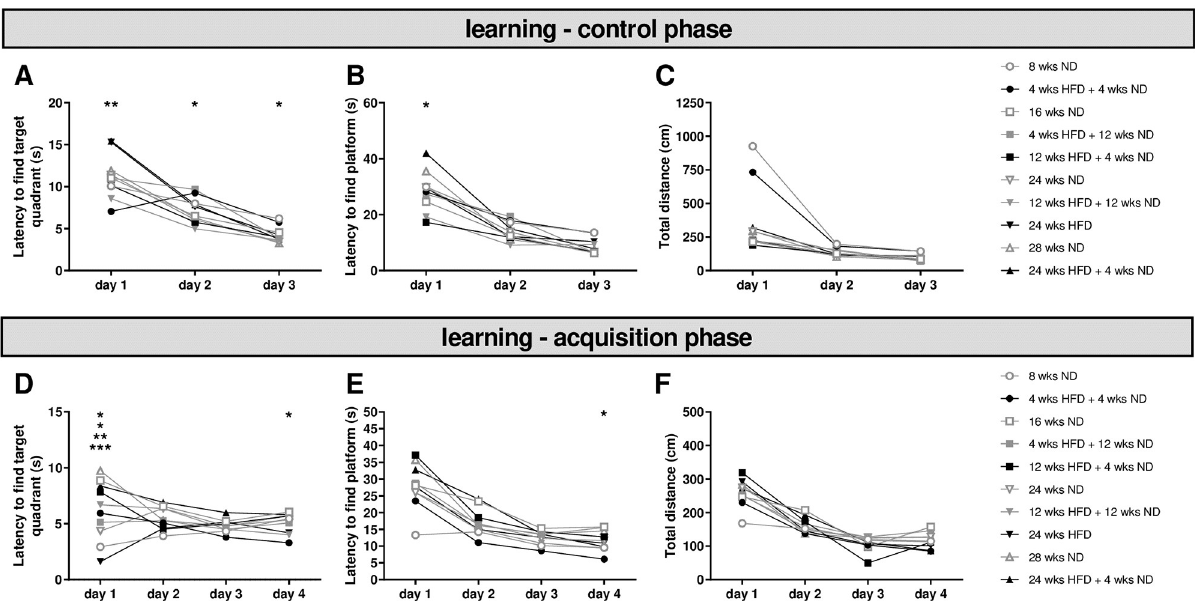
Fig 4. Learning is not affected by HFD. Before performing the MWM test, mice had three days to find the marked platform underneath the water by using visual information (control phase). (A) Diet had an effect on the latency to find the target quadrant. (B) We observed an effect on the latency to find the platform only on the first day regarding diet. (C) The motor activity was not affected by diet and general learning performance did not differ with respect to diet/dietary change. After the control phase, mice were trained for four days to perform the MWM test (acquisition phase). (D) Latency to find the target quadrant differed for some groups on day one and four, but learning did not change due to diet. (E) Latency to find the platform underneath the water surface showed no effect of diet. Performance up to day four did not differ relative to diet. (F) Motor activity was similar for mice on different diets. Data are presented as mean values and error bars indicate SD; 8 wks ND n = 12, 16 wks ND n = 24, 24 wks ND n = 30, 28 wks ND n = 12, 4 wks HFD + 4 wks ND n = 12, 12 wks HFD + 4 wks ND n = 7, 4 wks HFD + 12 wks ND n = 12, 12 wks HFD + 12 wks ND n = 12, 24 wks HFD n = 11, 24 wks HFD + 4 wks ND n = 9; Two-way ANOVA; ��� p < 0.001; �� p < 0.01; � p < 0.05.